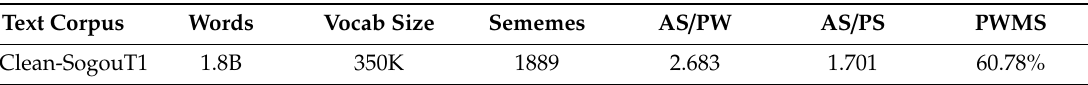
Table 1. Text corpus statistics. AS / PW, average senses / per word; AS / PS, average sememes / per sense; PWMS, percentage of words that have multiple